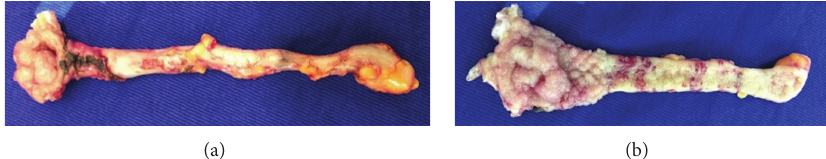
Figure 2: (a) An external view of the surgical specimen of the appendix showing the serrated adenoma protruding through the ostium of the appendix. (b) The internal view of the appendix lumen showing the adenoma arising in the appendix mucosa and spreading to the